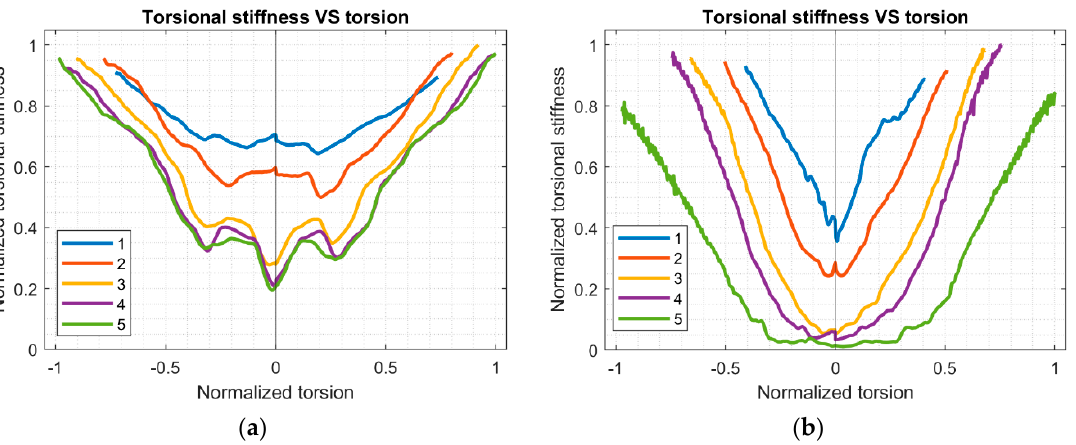
Figure 8. ( a ) Trends of the torsional stiffness as a function of torsion of gear A over time normalized with respect to the measurements in sample 5. ( b ) Trends of the torsional stiffness as a function of torsion of gear B over time normalized with respect to the measurements in sample 5.